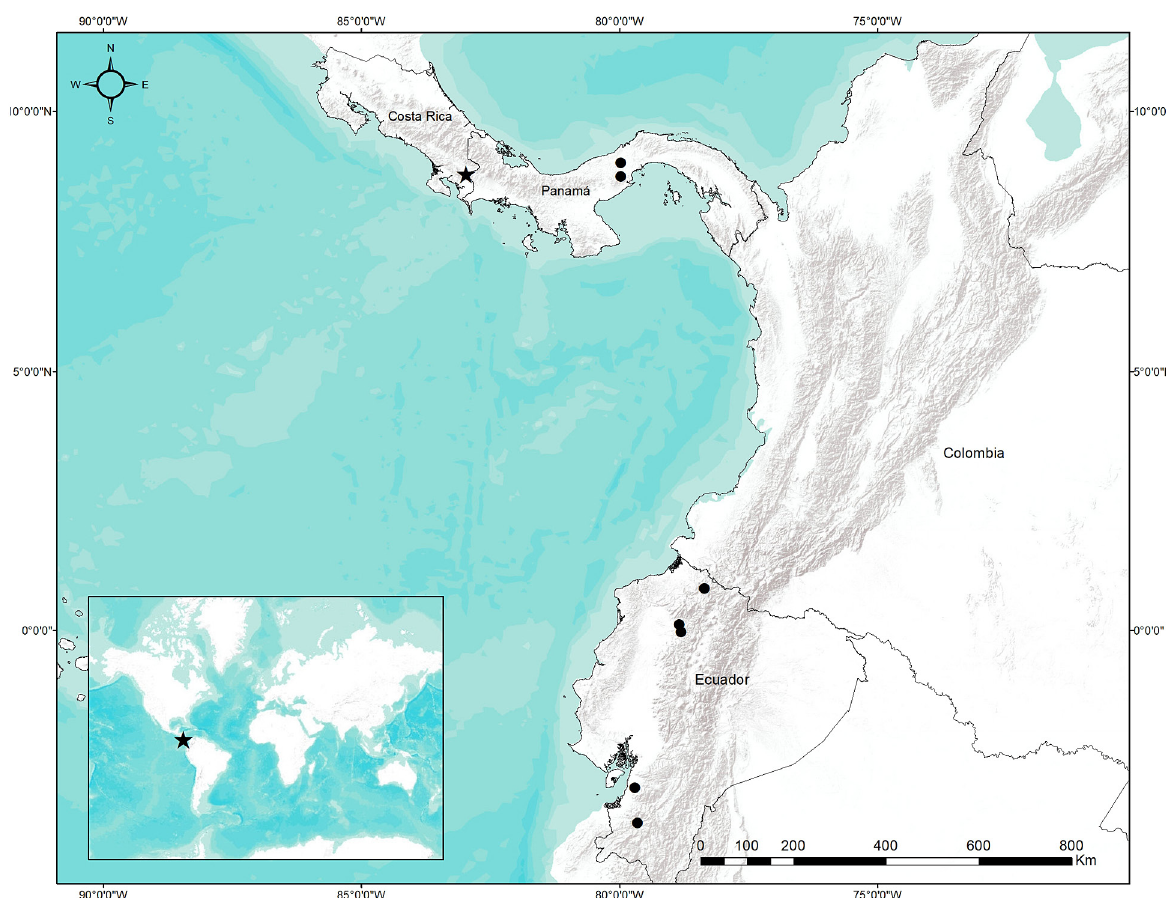
Figure 1. Map showing reported localities for Tweedy’s Crab-eating Rat, Ichthyomys tweedii . Black star, new record: Las Cruces Biological Station, San Vito, Puntarenas Province, Costa Rica (08°47’05.60”N, 082°57’51.01”W, datum